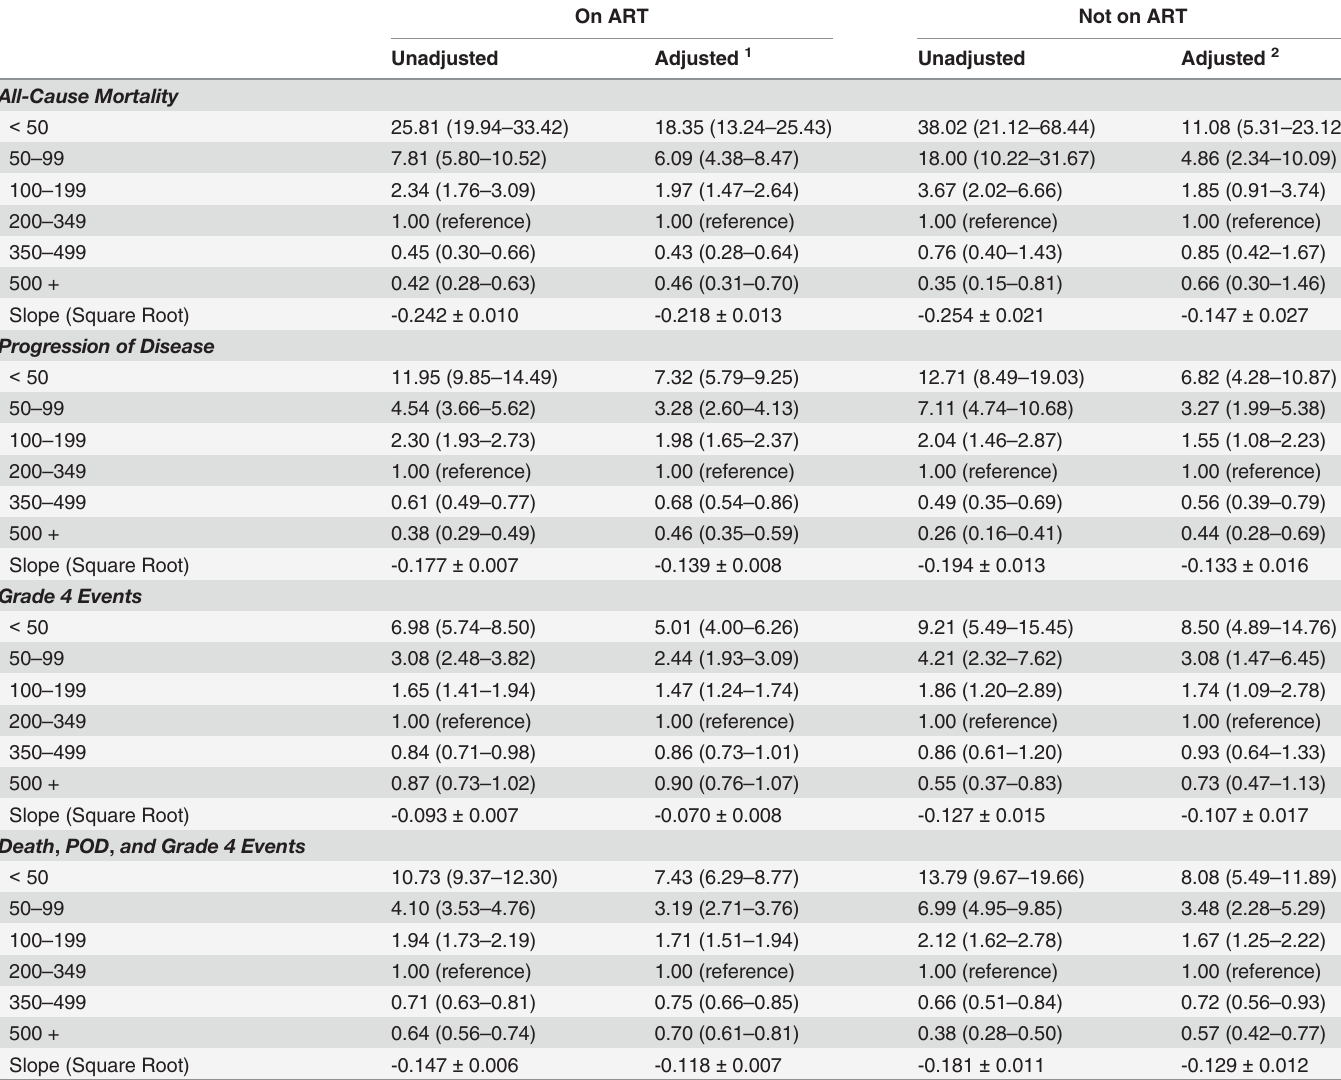
Table 4. Relative Rates of Morbidity and Mortality by Latest CD4 Count (cells/mm 3 ) and ART Status: Morbidity and Mortality